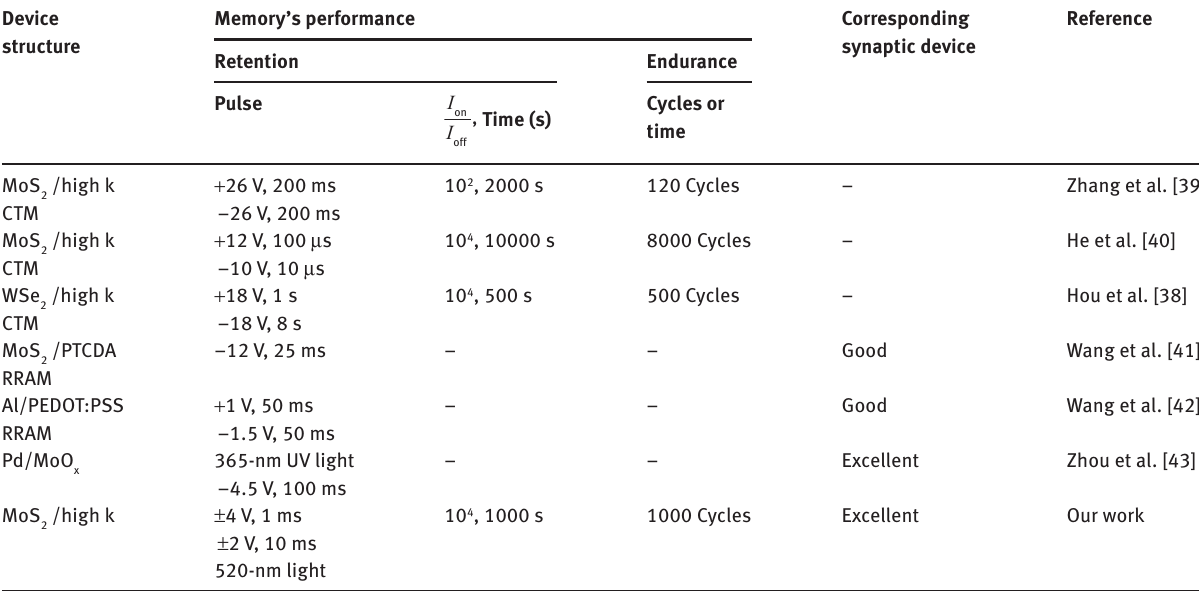
Table 1: Comparison of CTM and synapse device performance.